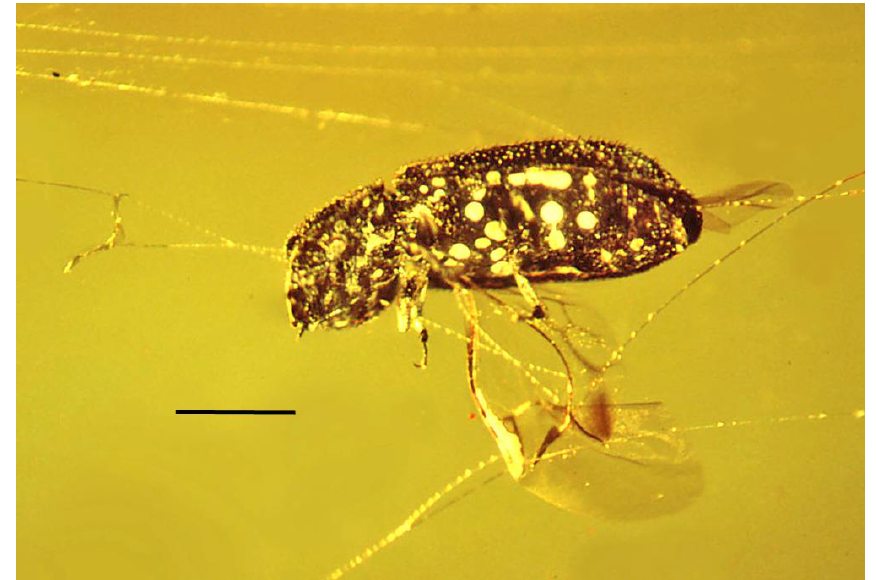
Figure 12. Colydiine beetle (Coleoptera: Zopheridae) in spider web in Dominican amber. Scale bar = 1.0 mm.